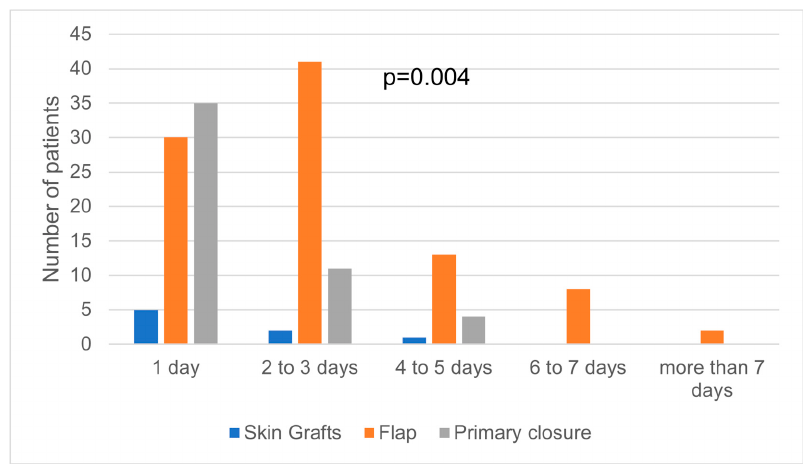
Figure 4. Correlation between tumor stage and days of hospitalization. Medicina 2023 , 59 , 220